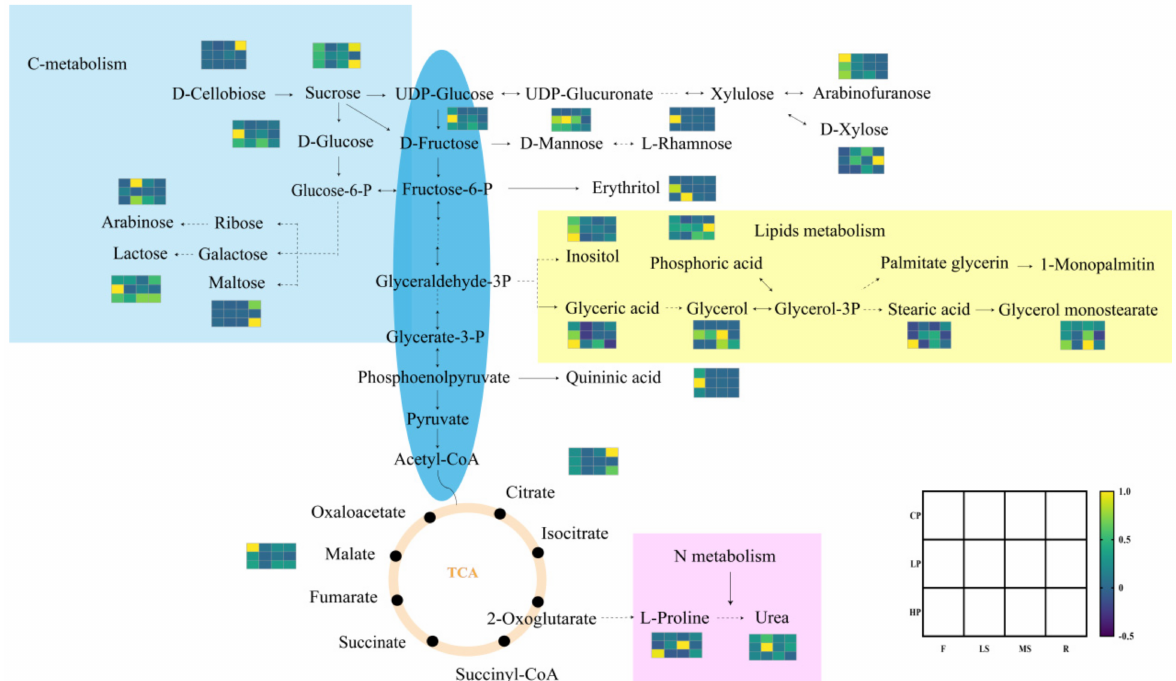
Figure 7. Visualization of primary metabolites in biochemical pathways, and the cluster analysis and heat map for metabolite classification in phosphorus